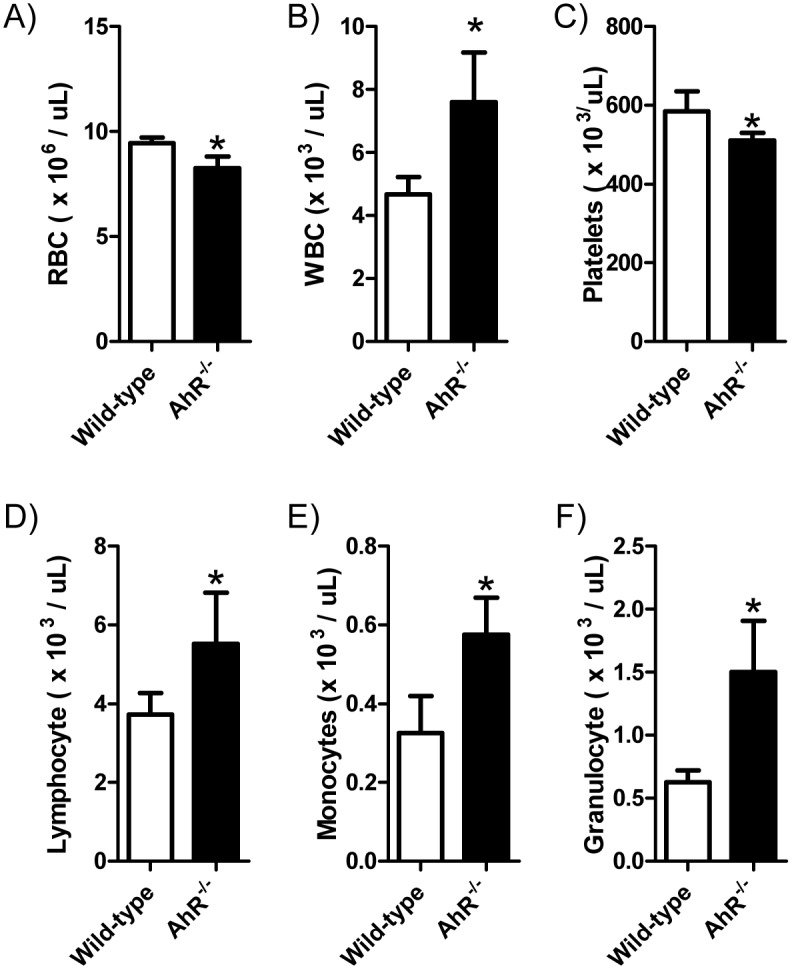
Aged AhR-KO mice have altered composition of peripheral blood.Blood was drawn from the retro-orbital plexus of 18-month-old WT and AhR-KO mice and analyzed for cell counts (A-F). Data are shown as mean +/- S.D. n = 9 mice per group. * values significantly different from WT control (p<0.05)